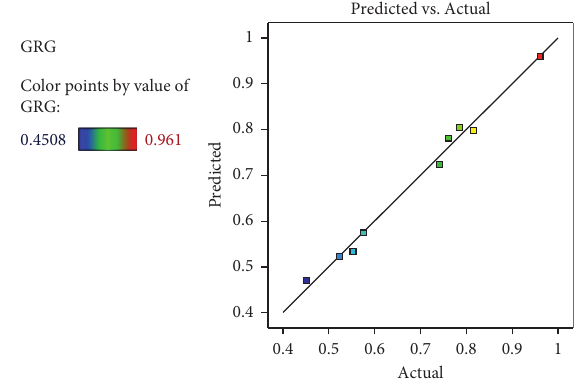
Figure 20: Predicted GRG data vs Actual GRG data.